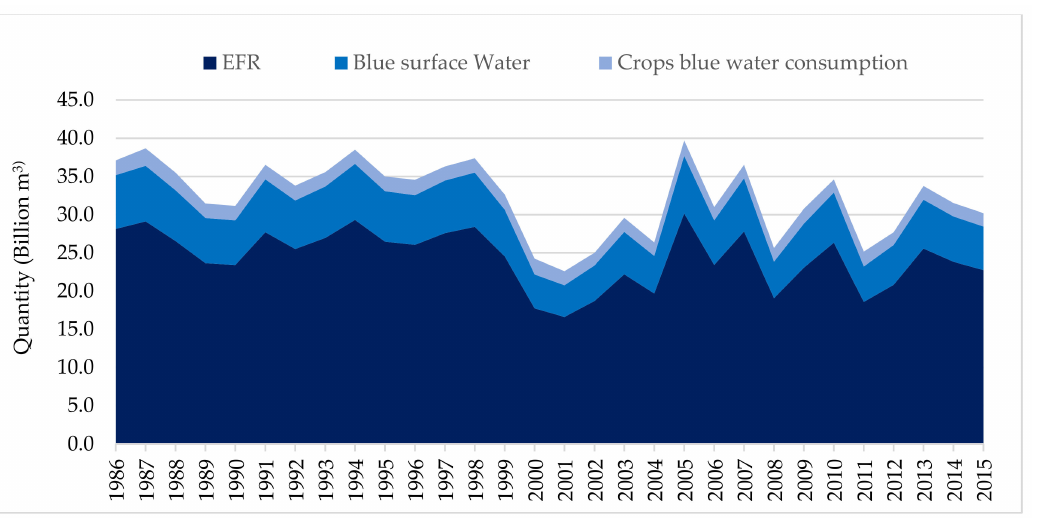
Figure 7. Contribution of EFR, non-utilized blue surface water, and crop water consumption in Peshawar Basin